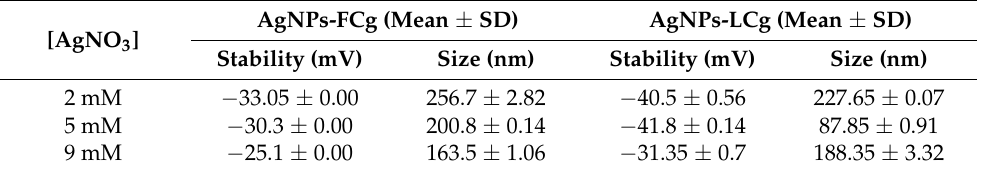
Table 2. Zeta potential analysis parameters of AgNPs-LCg and AgNPs-FCg.